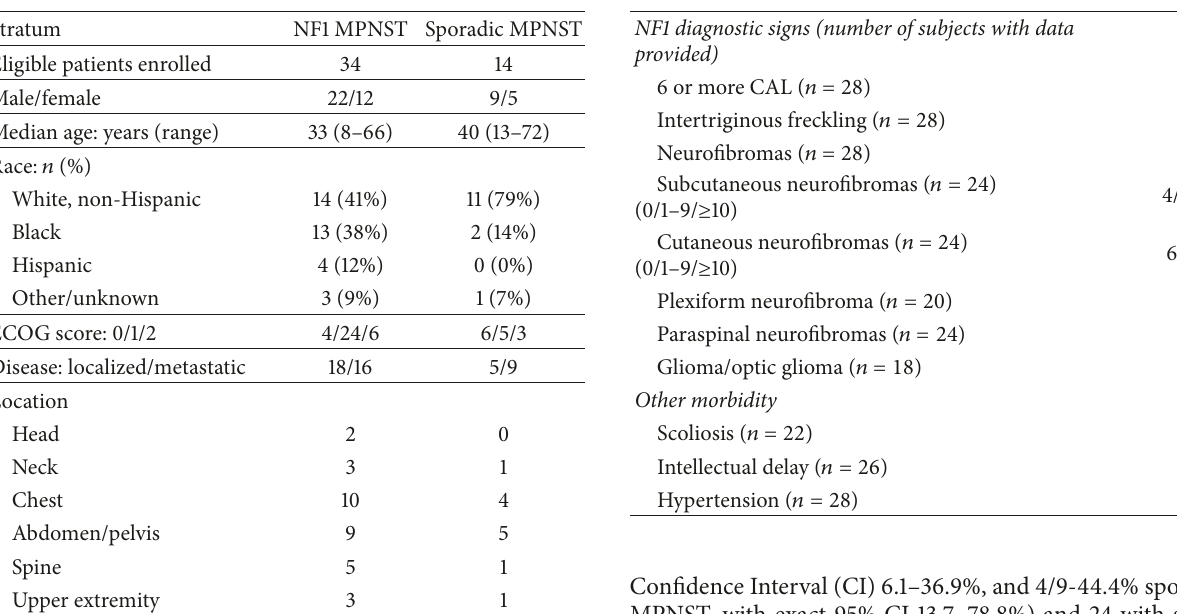
Table 1: Patient characteristics at enrollment and response evalua- tion.